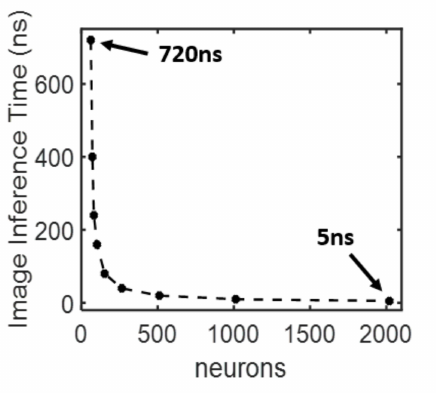
Figure 10. Inference time of a single 12 × 12 pixel image alongside the number of physical neurons at the